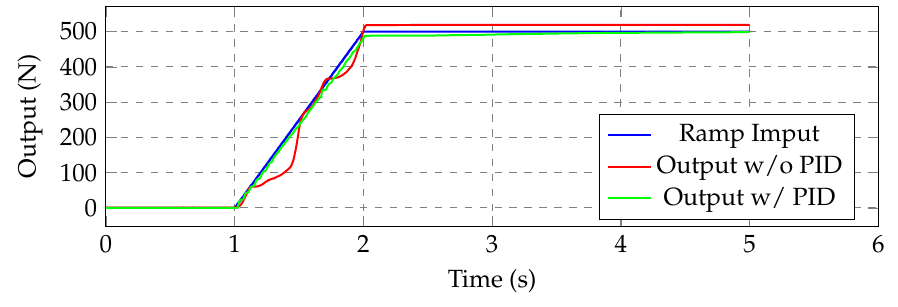
Figure 5. Torque ripple cancellation with PID based force controller.